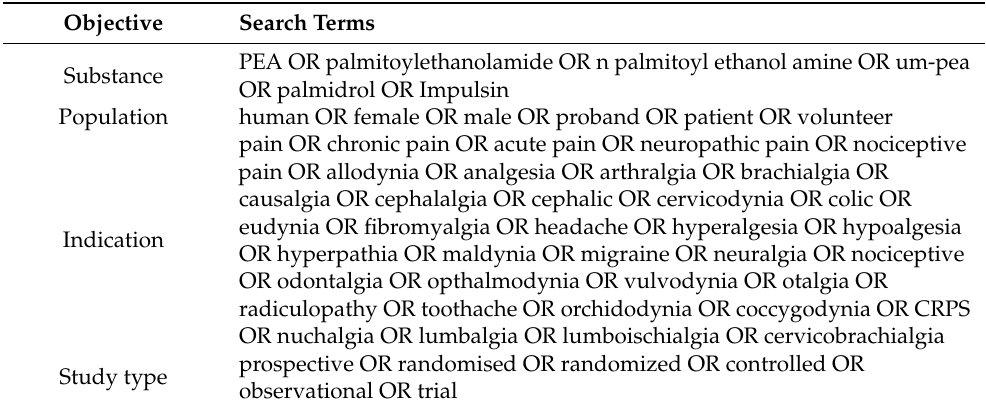
Table 1. Overview of the literature search